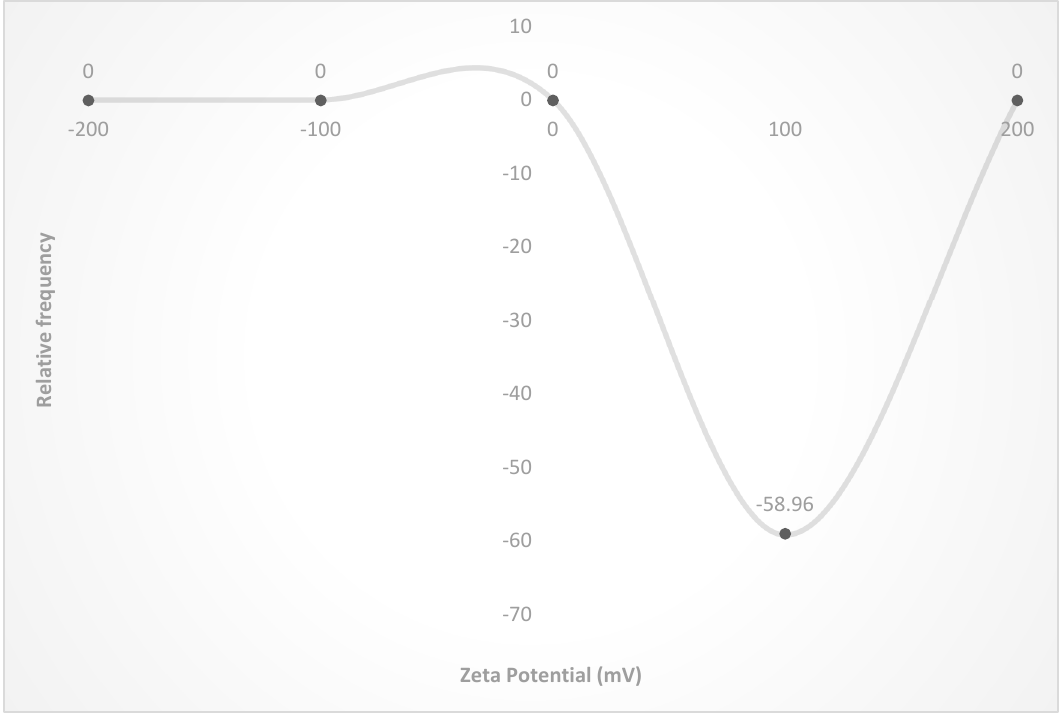
Figure 6. Zeta potential of A. indica -based AgNPs.